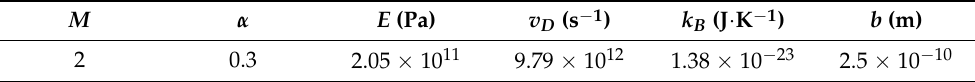
Table 1. Values of factors used in Equations (11) and (12) [23,25].